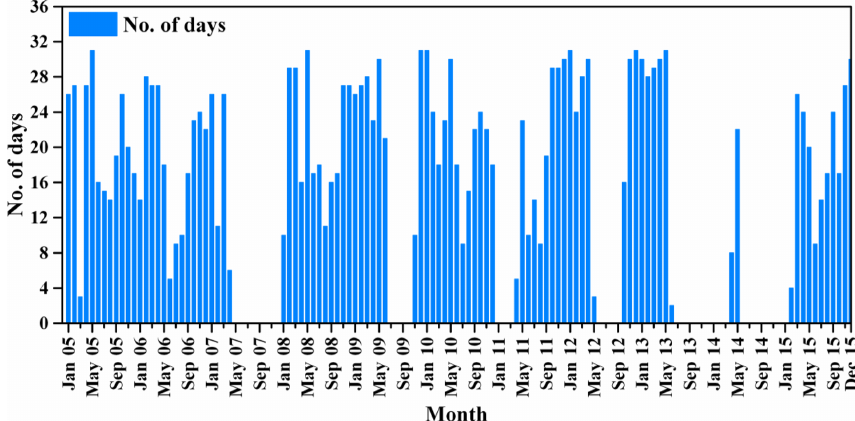
Figure 4. Month-wise distribution of observation days during the study period from January 2005 to December